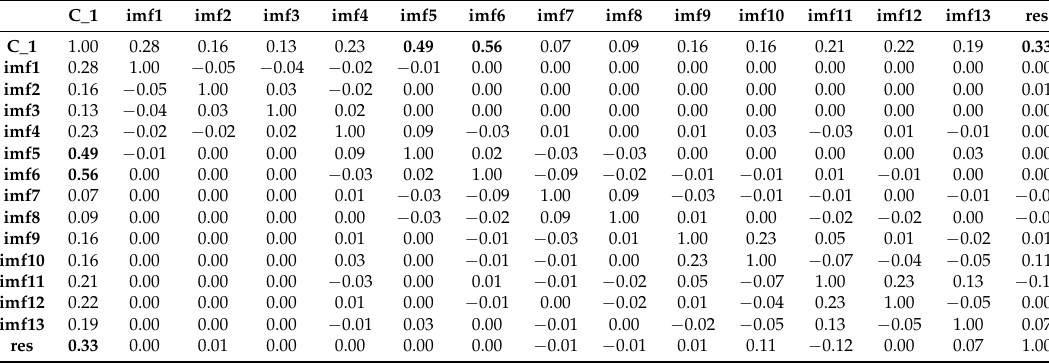
Table A4. C_1 load component correlation coefficient